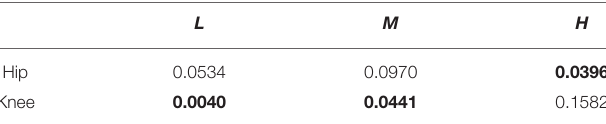
TABLE 2 | Gait kinematics—Statistical significance for the considered loading conditions.